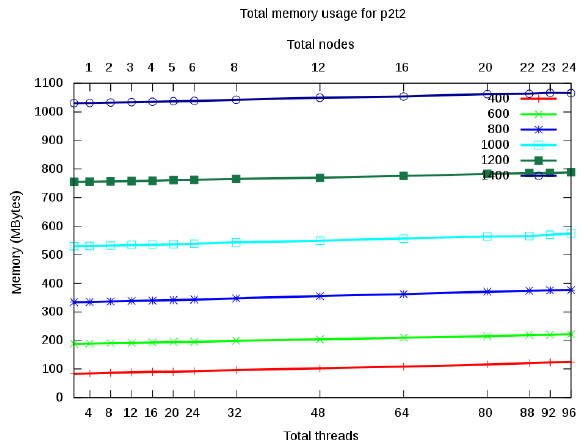
Figure 4: Memory usage.